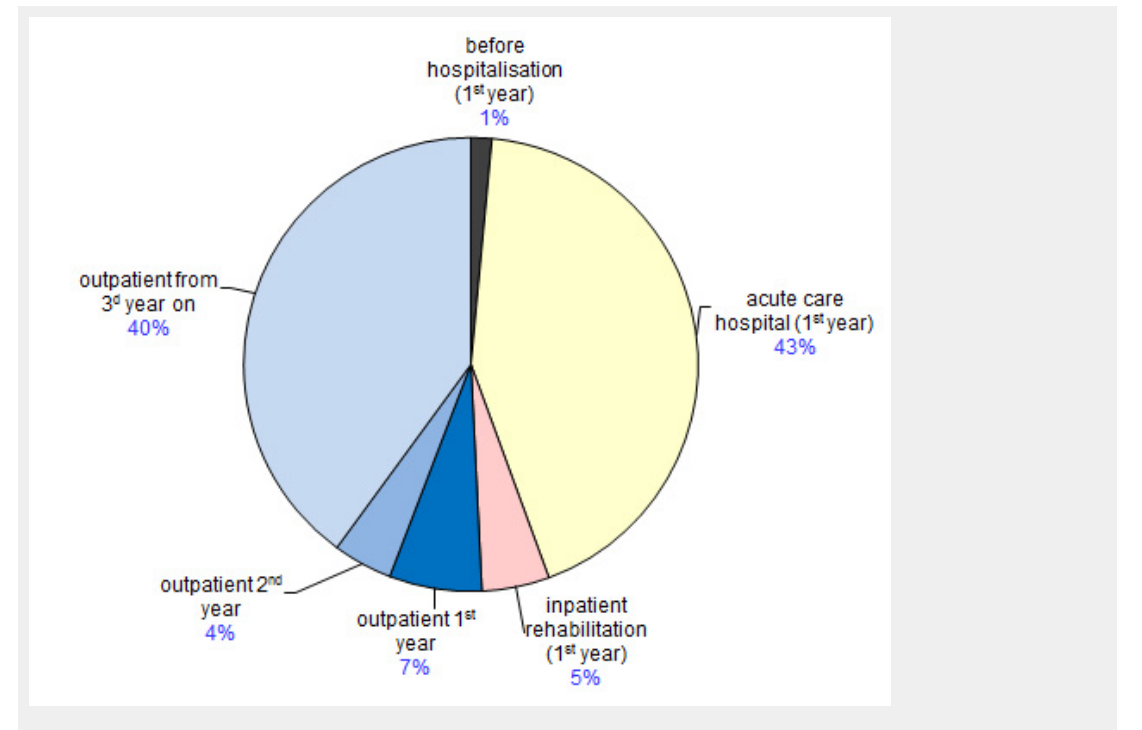
Figure 5 Total direct cost of ACS in Switzerland in 2008 – societal perspective (%). Own calculation on the basis of a variety of